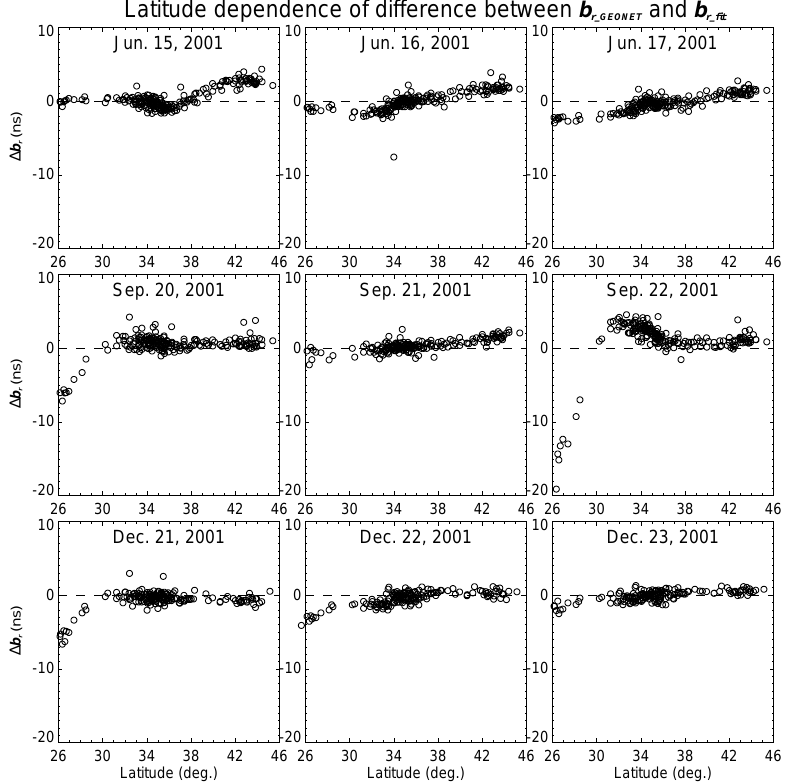
Fig. 13. Latitude dependence of the difference between biases determined from the two different methods for the 9 days analyzed. The dashed line referring to no difference is plotted in each panel for easy